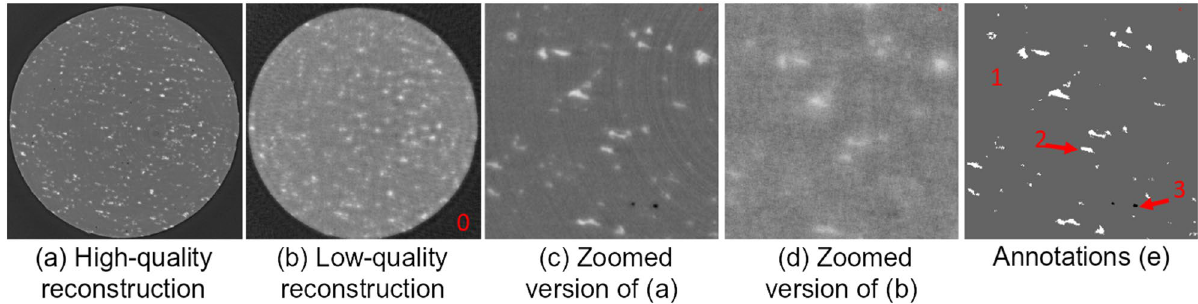
Figure 1. Cross section of our real-world dataset reconstructions and annotations. ( a ) Filtered Back-Projection (FBP) 36 reconstruction from 3601 projections 37 (these are cropped and centered around the metallic pin of Label 1), ( b ) Conjugate Gradient Least Squares (CGLS) 38 reconstruction from 91 projections 39 (these are cropped and centered around the metallic pin of Label 1), ( c ), ( d ) are zoomed versions of ( a ), ( b ) respectively and ( e ) are annotations for the same area 40 . Label 0 in ( b ) refers to the air outside the base-material, Label 1 in ( e ) refers to the base-material, Label 2 are the magnesium deposits and Label 3 are the gas